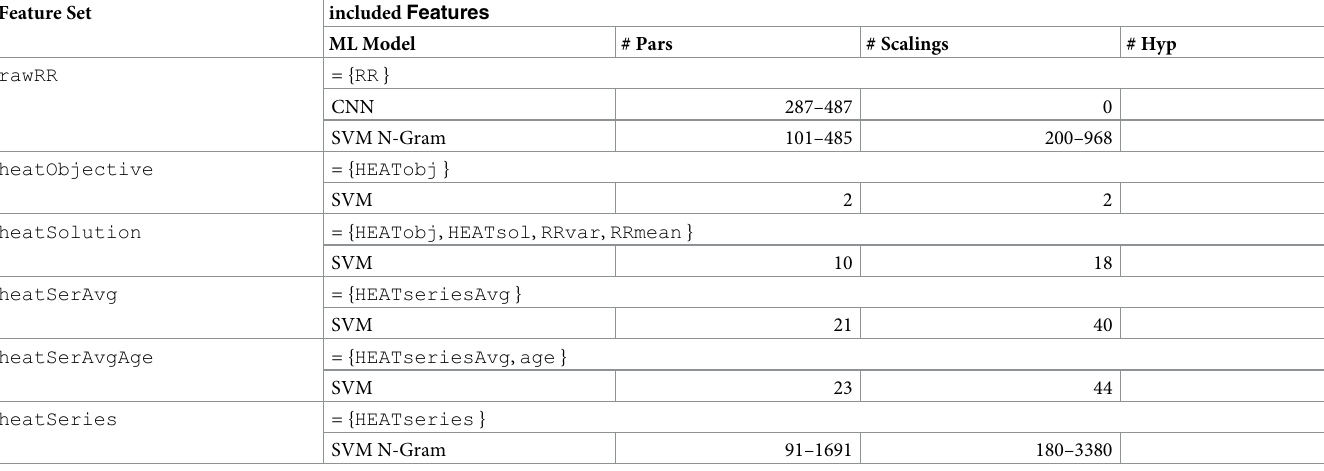
Table 1. Number of optimization parameters (pars), scaling factors, and hyperparameters (hyp) for the different feature sets and ML models. Feature